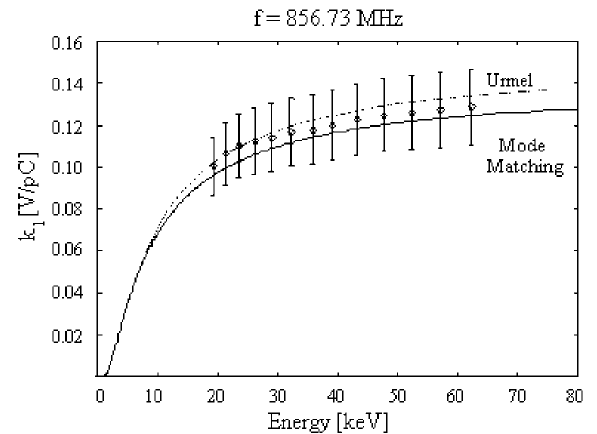
FIG. 5. Loss factor as a function of bunch energy; com- parison between theoretical and experimental results at f (cid:1) 856.73 MHz.